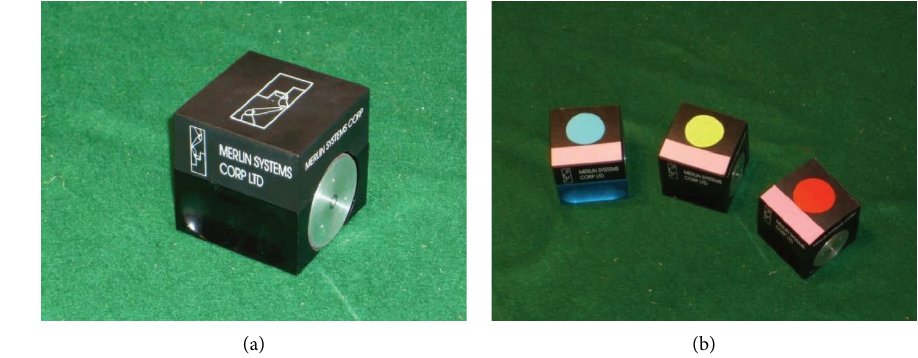
Figure 12: (a) Robotic vehicle and (b) vehicles with